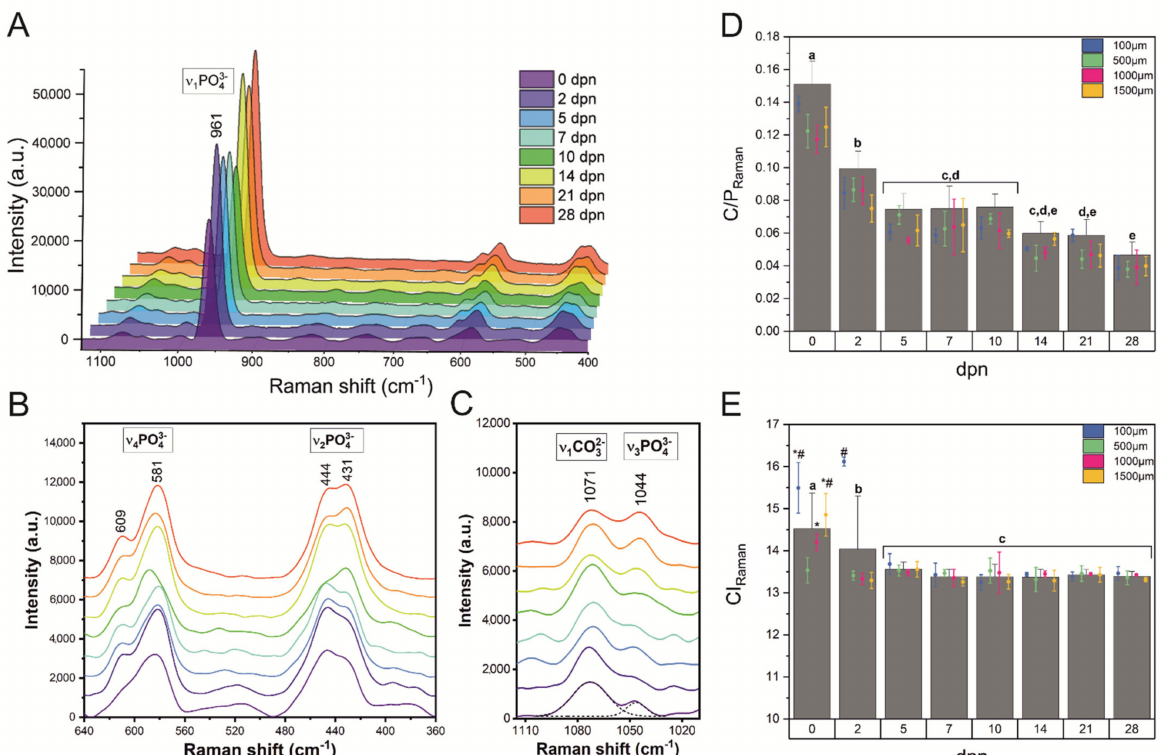
Figure 8. Raman spectra of the selected point along the spiny-mice incisor labial surface in the different stages of maturation ( A ), the spectral region of the ν 2 , ν 4 phosphate group ( B ) and the spectral region of the ν 3 phosphate and the ν 1 B-type carbonate groups ( C ). ( D ) The carbonate- to-phosphate ratio expressed as the area of the 1070 cm − 1 divided by the area of 960 cm − 1 (C/P). The band parameters were obtained by fitting the two Gaussian-Lorentzian curves in the region of 1030–1100 cm − 1 (shown only a sample fitting). ( E ) The crystallinity index expressed as the FWHM of 960 cm − 1 (CI) obtained for the four measurements sites collected from 100, 500, 1000 and 1500 µ m distance from the tip of the incisor. ( D , E ) were prepared in relation to days of postnatal life (dpn; columns) and distance from the incisor tip (error bars plot) and are presented with corresponding statistics as mean ± SD. Different letters indicate significant differences in groups (at p < 0.05), and symbols (*, #) for CI Raman values depending on the